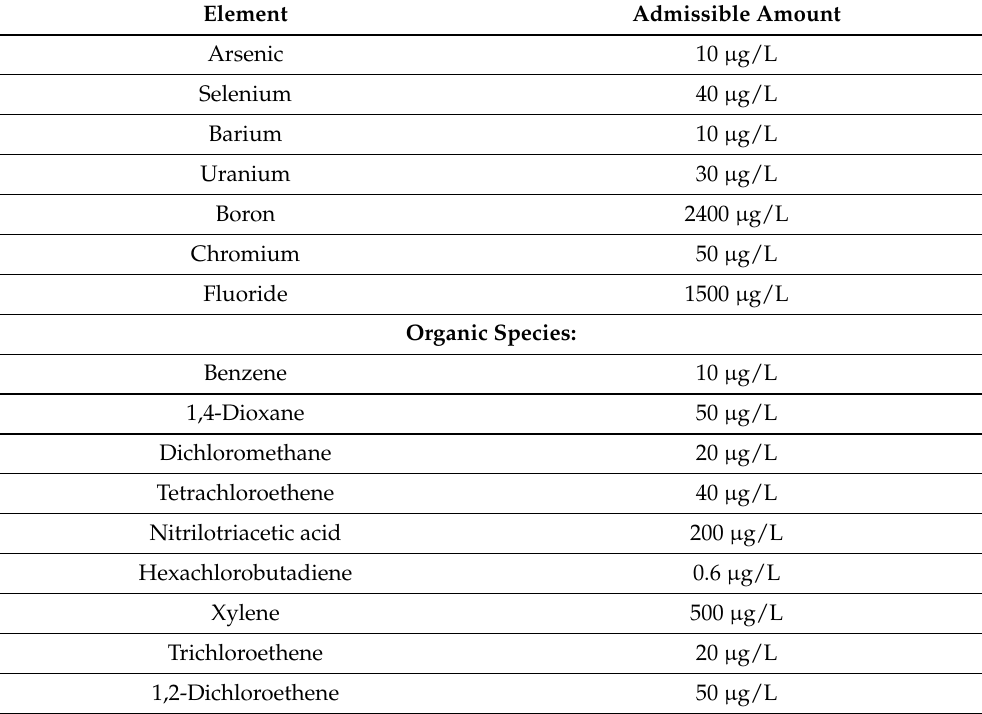
Table 1. Elements and their admissible amounts for drinking water as mentioned by the WHO